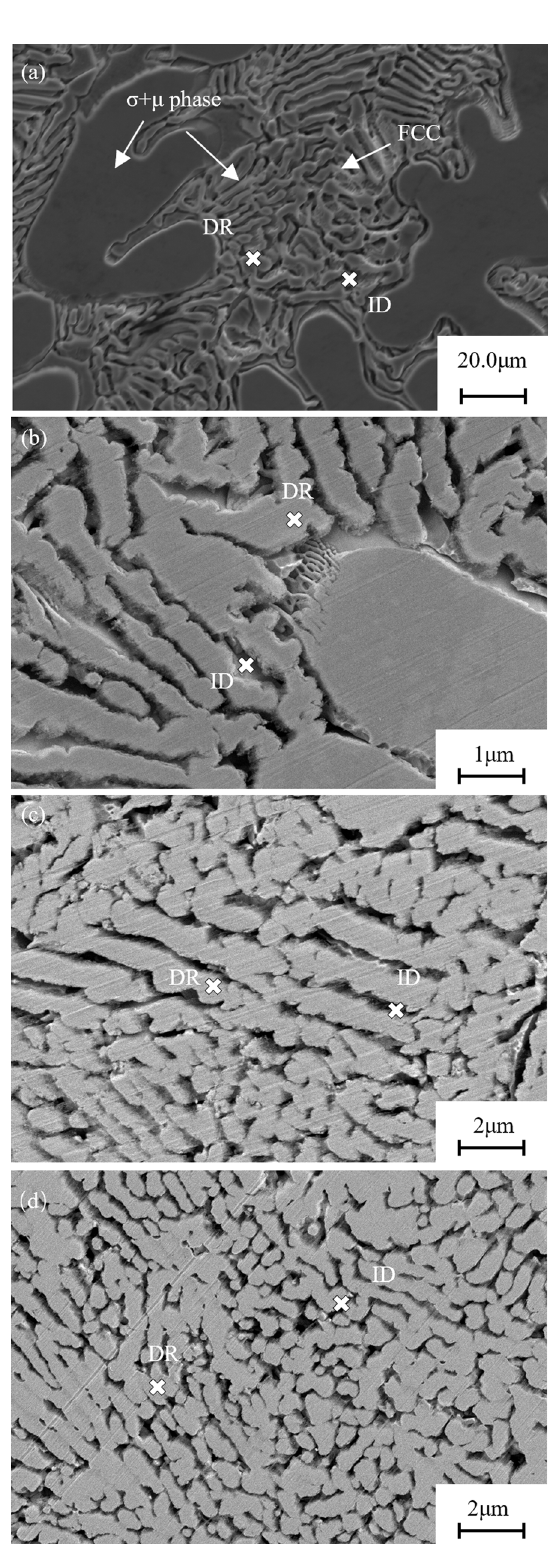
Figure 2: SEMimages of FeCoCrNiMo alloy at di ff erent annealing temperatures: ( a ) As - cast, ( b ) annealing treatment ( AT )- 873 K, ( c ) AT - 1,073 K, and ( d ) AT - 1,273 K.